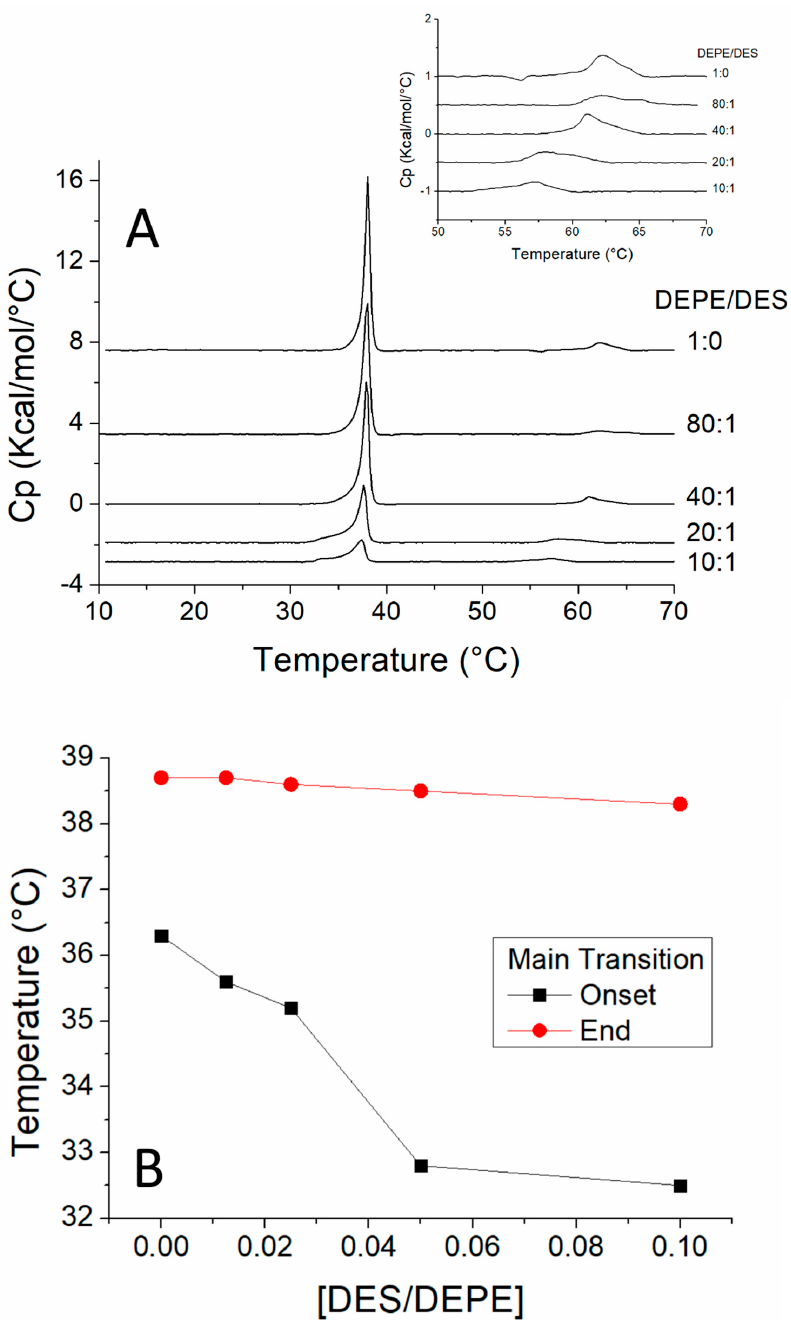
Figure 3. ( A ) Heating scan thermograms, obtained by using differential scanning for mixtures of DEPE and DES. The phospholipid/DES molar ratios are given on the traces. The transition of L α to H II phases (T H is the onset of this transition) is amplified in the insert. ( B ) Plot of DES/DEPE molar ratios versus temperature on which the temperatures corresponding to onset and end of phase transitions are plotted.